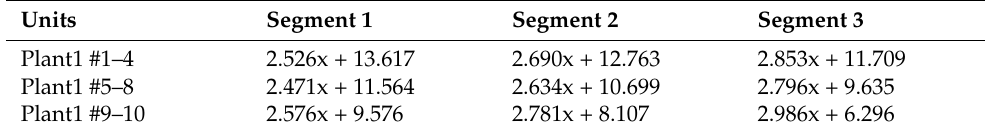
Table 4. Diesel Generator Linear Fuel Cost.